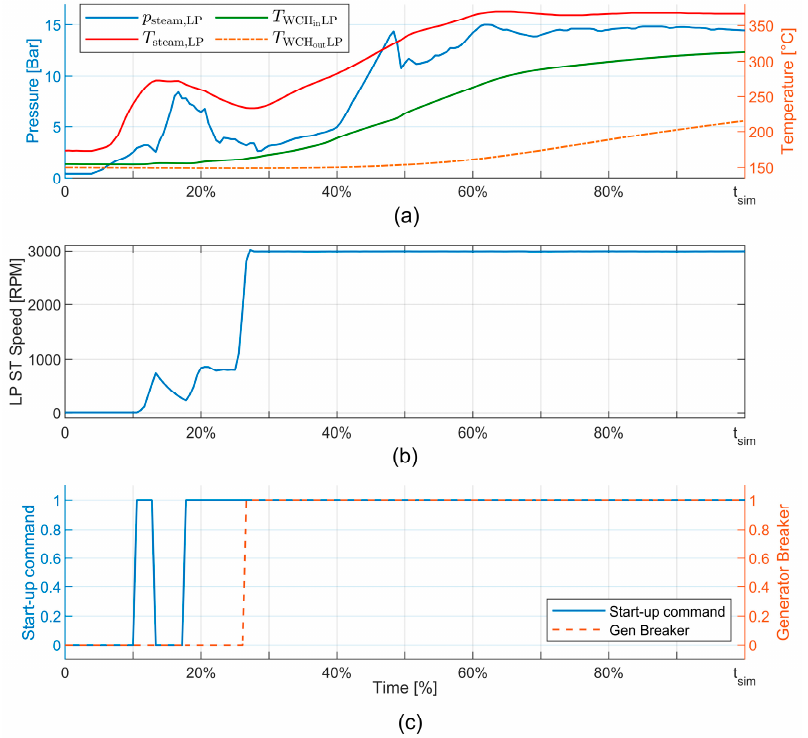
Figure 10. Case study for the power startup application. Steam conditions in terms of temperature and pressure, and temperature of the wheel chamber ( a ); rotor speed ( b ); startup and generator breaker commands ( c ).